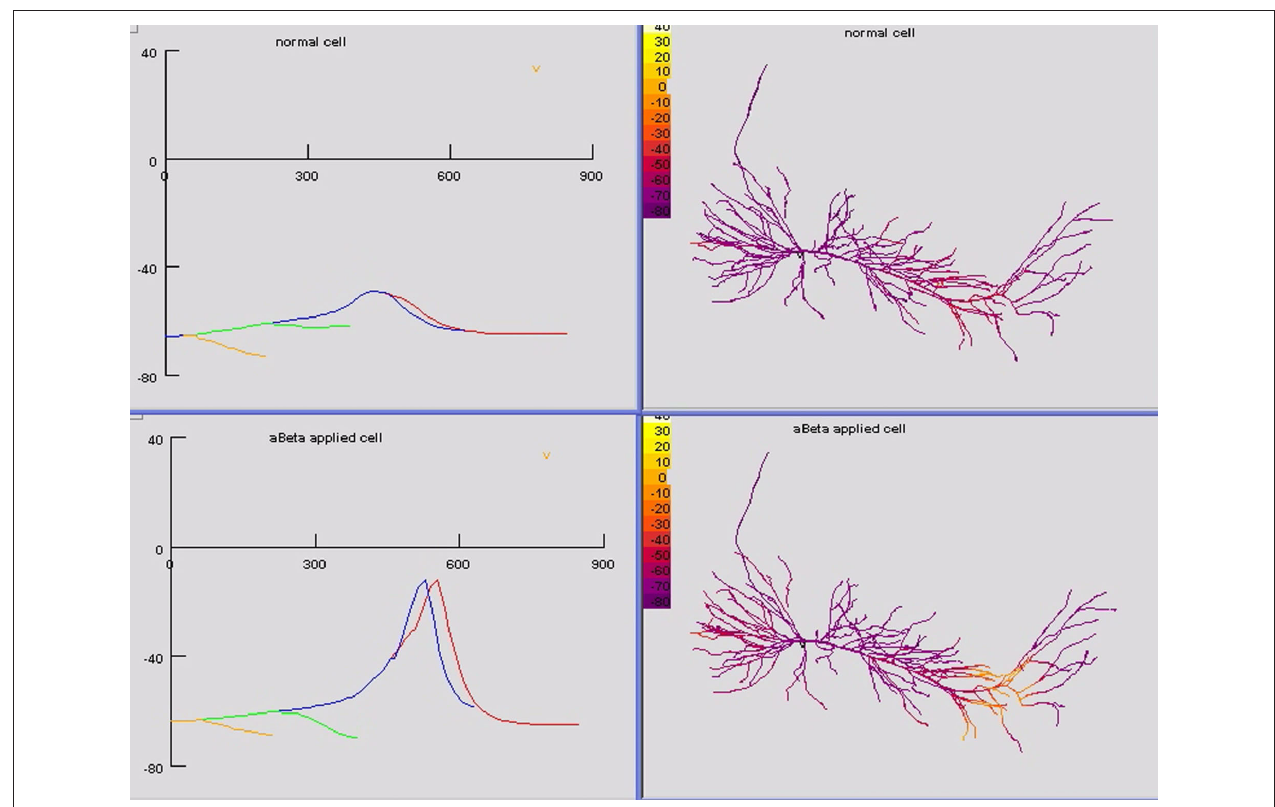
shown in left panel of Figure 1B ). The figures on the right display membrane potential throughout the model at the corresponding time. At this instant the bAP has died out in the normal model, but it continues to propagate into the apical tree of the a β -applied model. The movie is in the Supplementary Material.